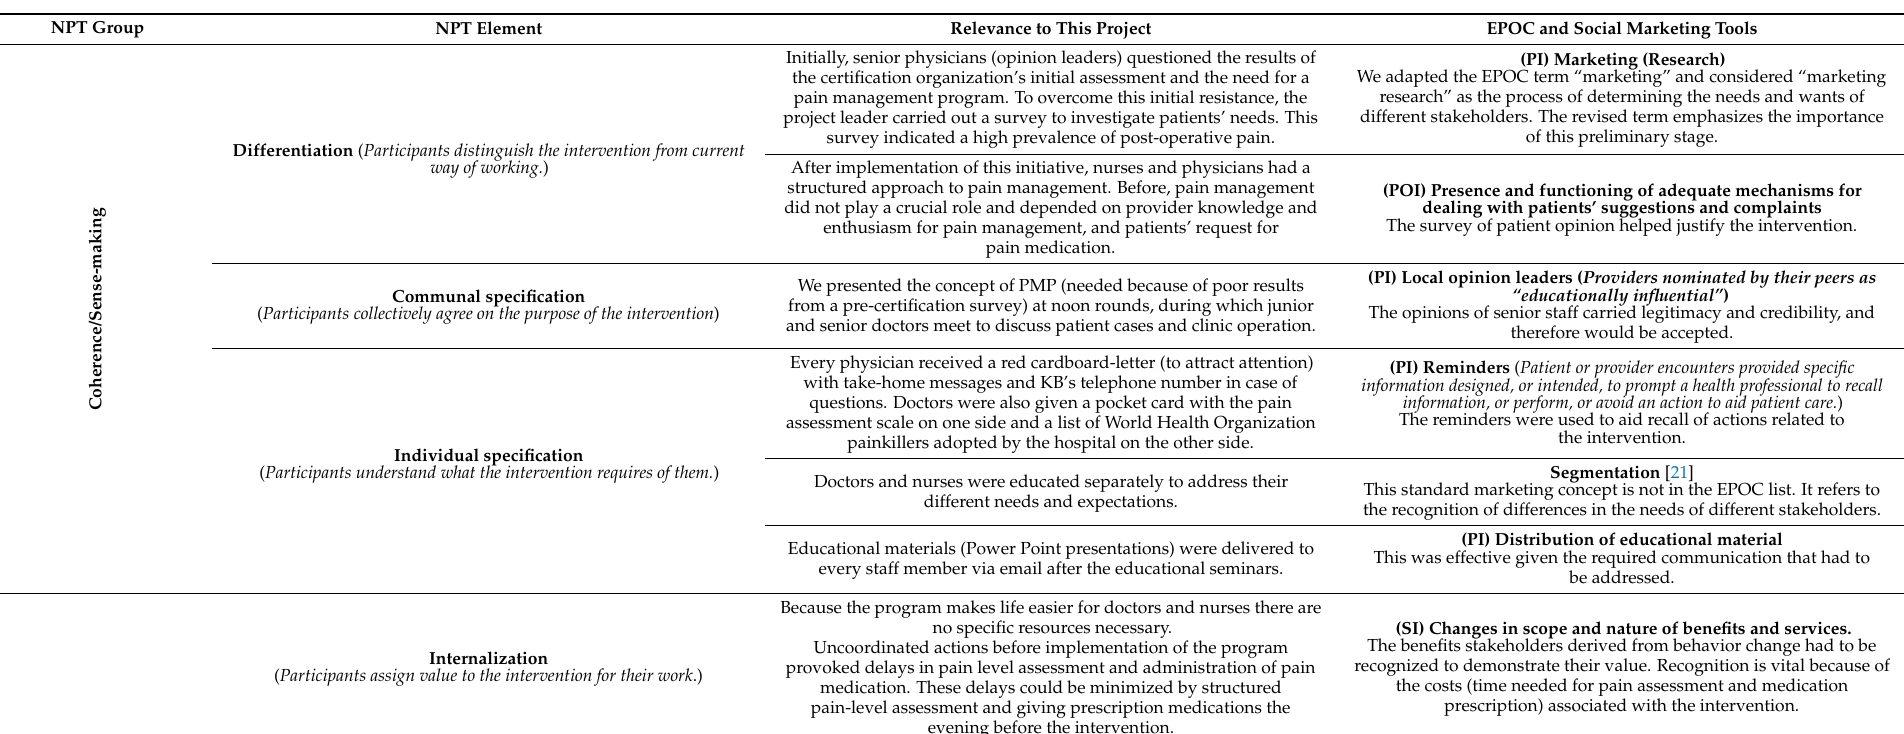
Table 1. NPT elements relevant to the program, and the EPOC and social marketing tools